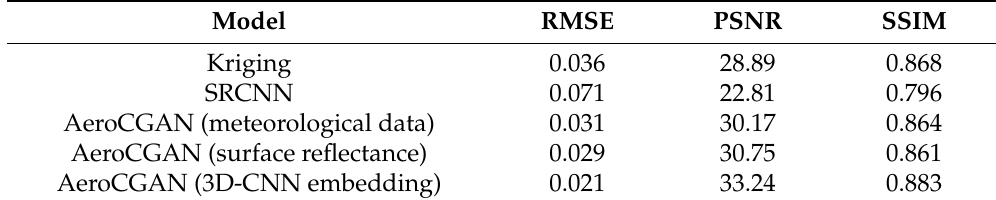
Table 3. Performances of different methods with three evaluation indices (using MODIS MAIAC